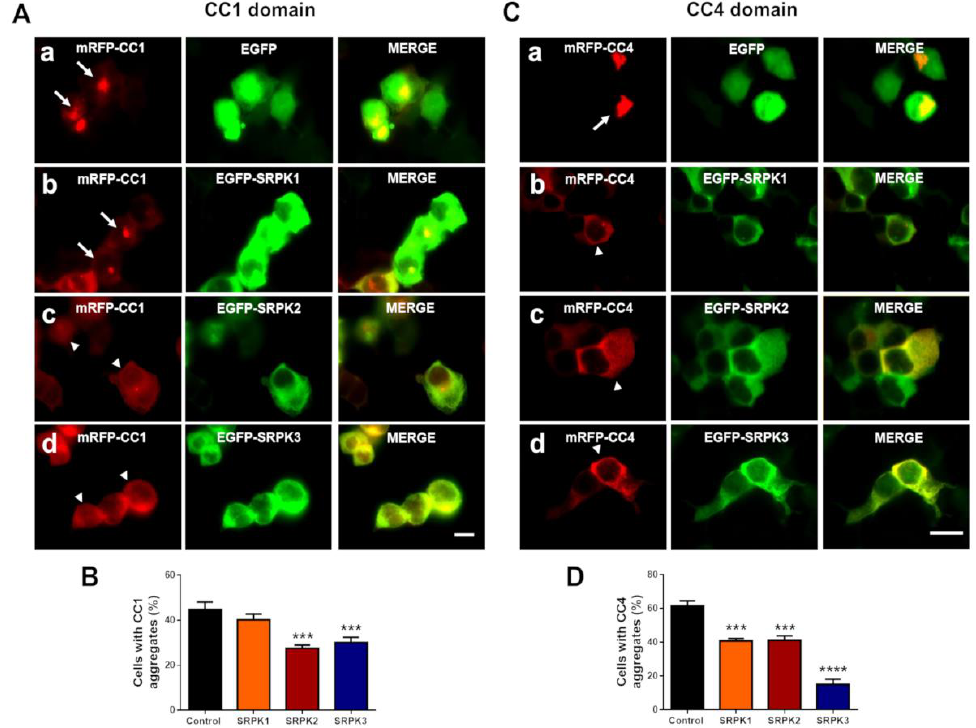
Figure 5. SRPKs disrupts the aggregation CC1 and CC4 domains of CAST1 / ERC2 in HEK293T. Representative images of HEK293T cells co-transfected with either EGFP (control) or EGFP-SRPK1, -2, -3 and mRFP-tagged ( A ) CC1 and ( C ) CC4 domains plasmids. Forty-eight hours later, the cells